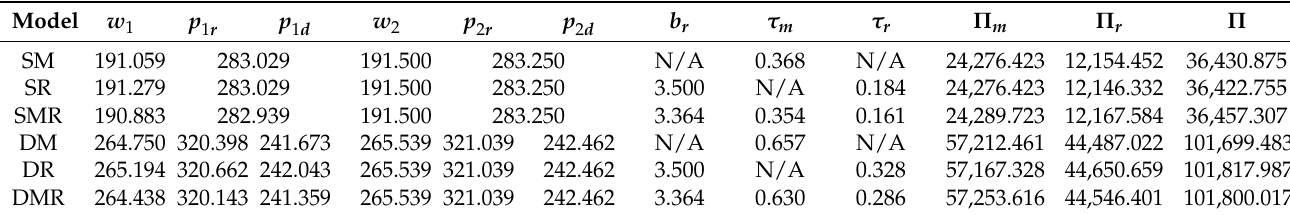
Table 3. The equilibrium